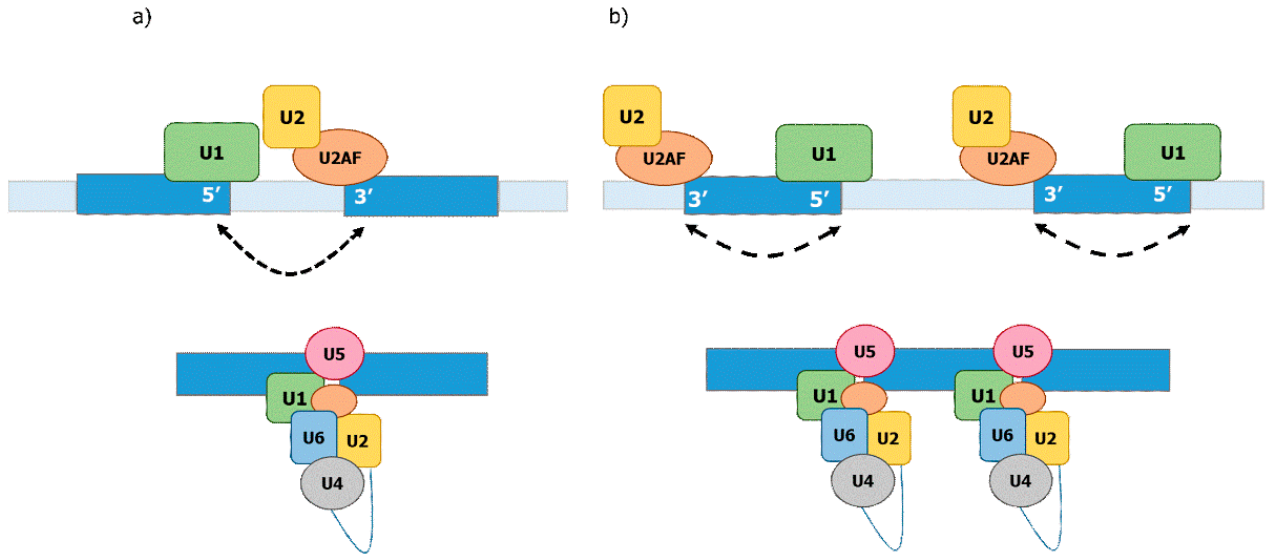
Figure 2. Definition of the exon–intron junctions. ( a ) Intron definition. ( b ) Exon definition. Darker blue bars indicate exons; lighter blue bars indicate introns; blue line indicate intron lariat.